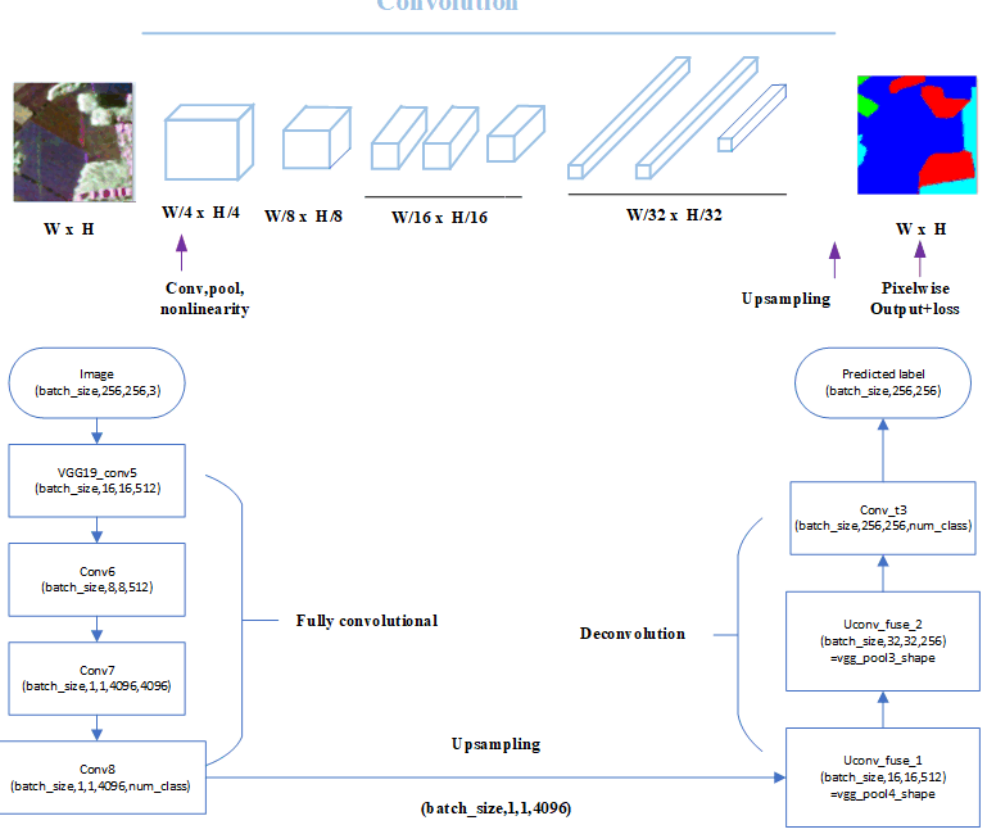
Figure 3. Structure of the prior network—FCN, and the flow of implementation. The network first uses a pretrained model VGG19 for feature extraction, and then connects three down-sampling convolutional layers and three up-sampling deconvolution